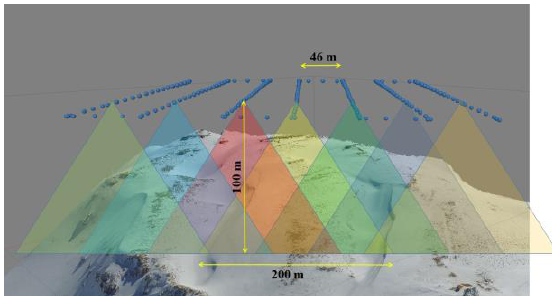
Figure 5: Example of obtained picture location and their side- lap at FA=100m.